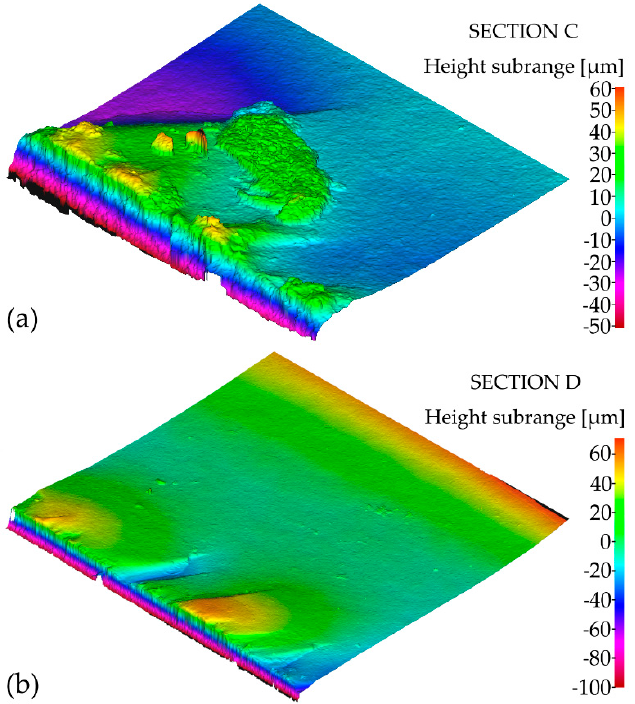
Figure 9. 3D contour diagrams for: ( a ) section C; ( b ) section D of the fracture surface after impact test.